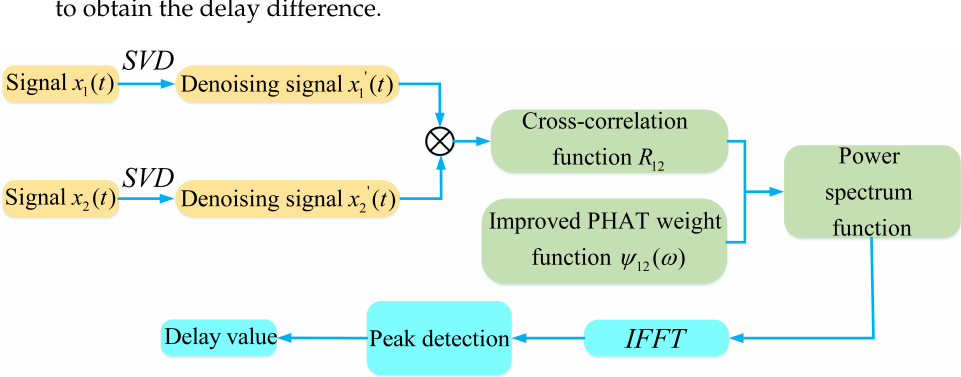
Figure 2. Flow chart of improved time delay estimation algorithm.